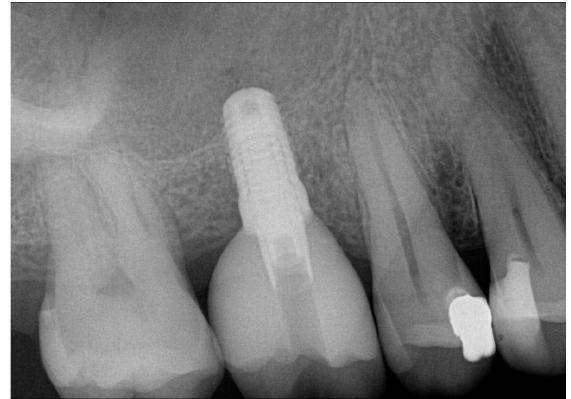
Figure 4. Final radiologic control shows no complications.